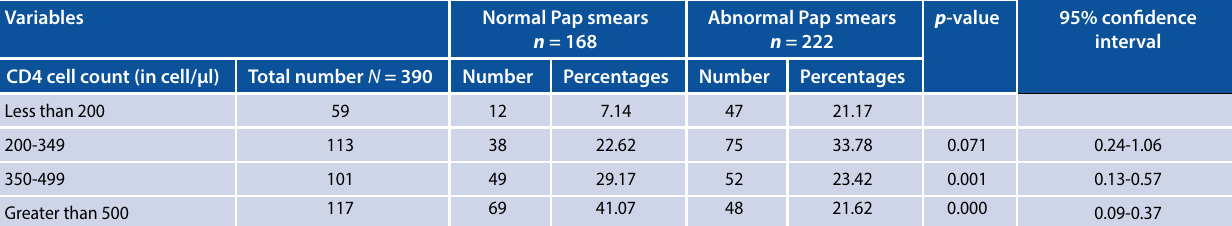
Table 5: Association CD4 cell count with abnormal pap smears